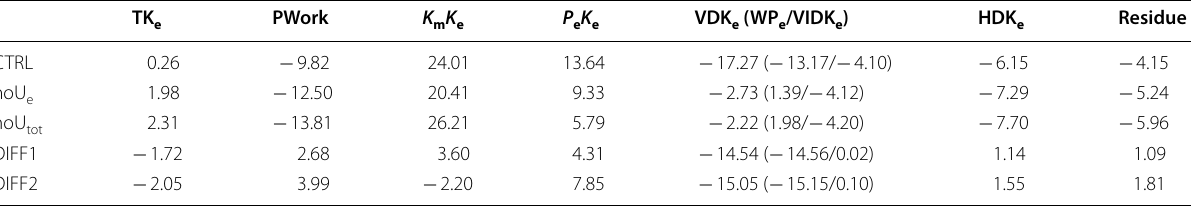
DIFF1 (CTRL-noU e ) shows the mesoscale eddy’s current feedback only. DIFF2 (CTRL-noU tot ) represents the entire current feedback. All values shown here are the 5-year wintertime mean. The values in the brackets represent WP e and VIDK e